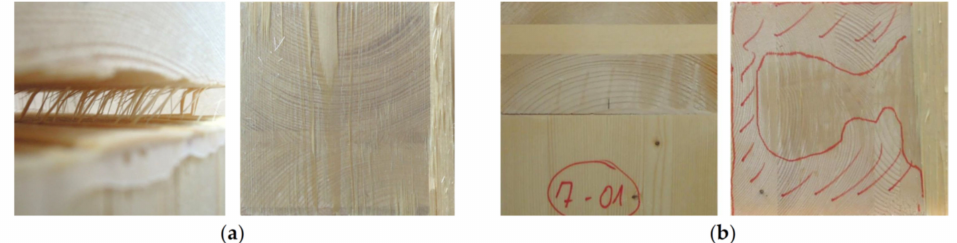
Figure 8. ( a ) inter interface fracture between specimen and load transmission block; ( b ) partial adhesion failure in the glue line between specimen and load transmission block (inter fracture).